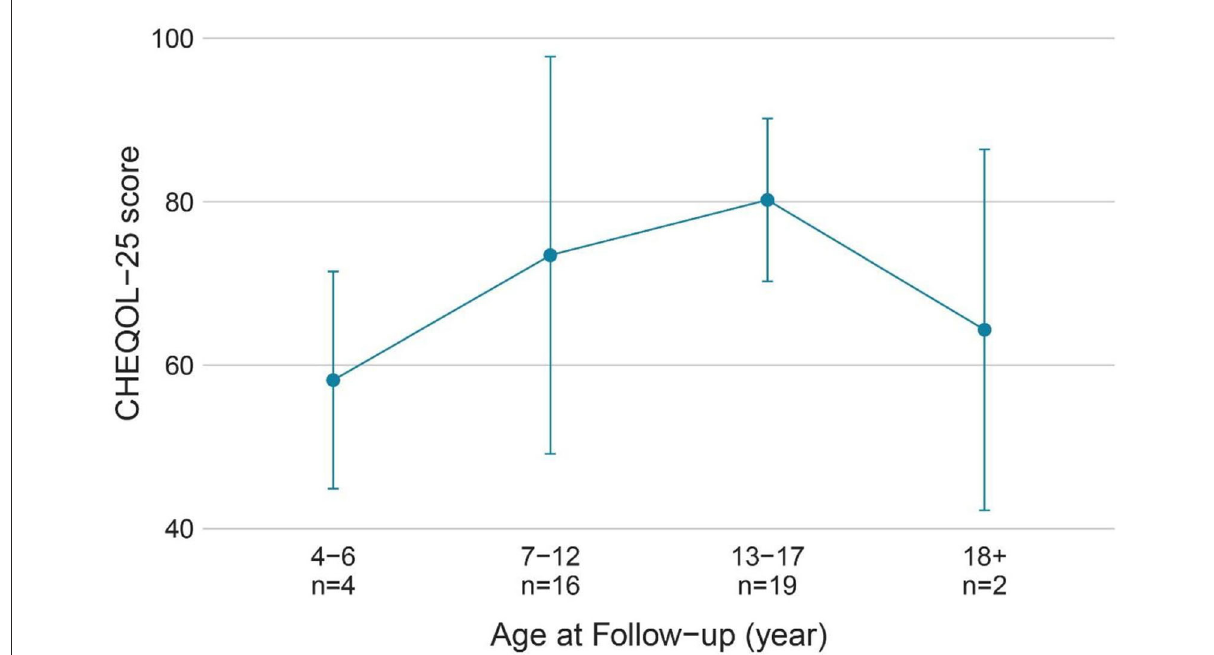
FIGURE3 QoL (CHEQOL-25 total score) group means ( ± standard error) of patients of different age groups. QOL, quality of life.